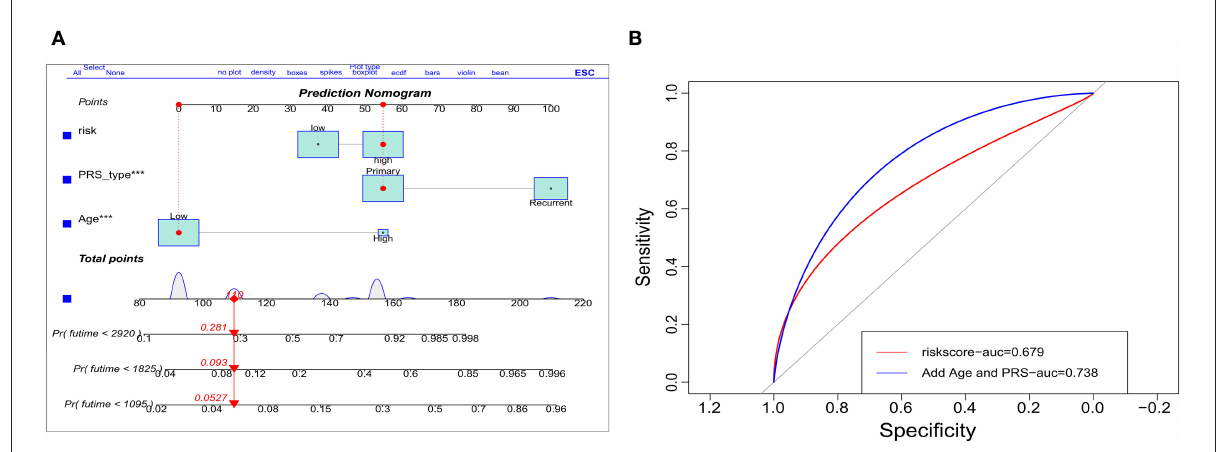
FIGURE2 Validation of the prognostic model. (A) Dynamic nomogram plots were generated to visualize the prognostic model, and (B) ROC curves demonstrate the predictive ability of risk scores (AUC = 0.679) vs. the use of risk level and age and primary-or-recurrent status (PRS)-type (AUC = 0.738).